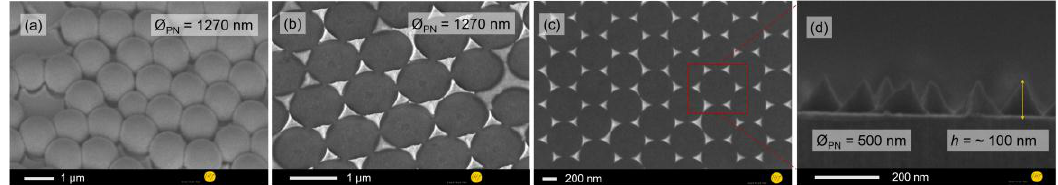
Figure 3. SEM images showing ( a ) the chromium covered polystyrene nanobeads and the remained equidistant chromium triangles after lift-off process for beads with diameters of ( b ) 1270 nm and ( c , d ) 500